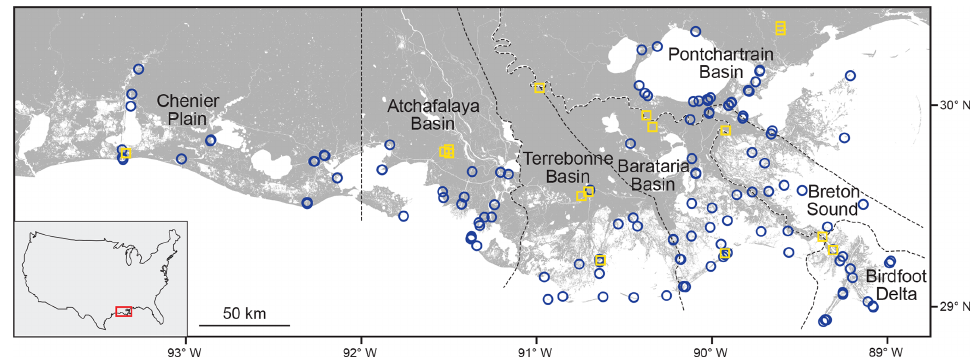
Figure 2. Location of tide gauges (circles, n = 131) and GNSS stations (squares, n = 17) in the Holocene landscape of coastal Louisiana. Dashed lines delineate geographic areas discussed in the text.